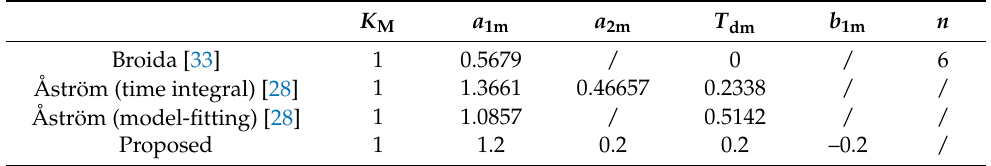
Table 2. The estimated model parameters for the process G P1